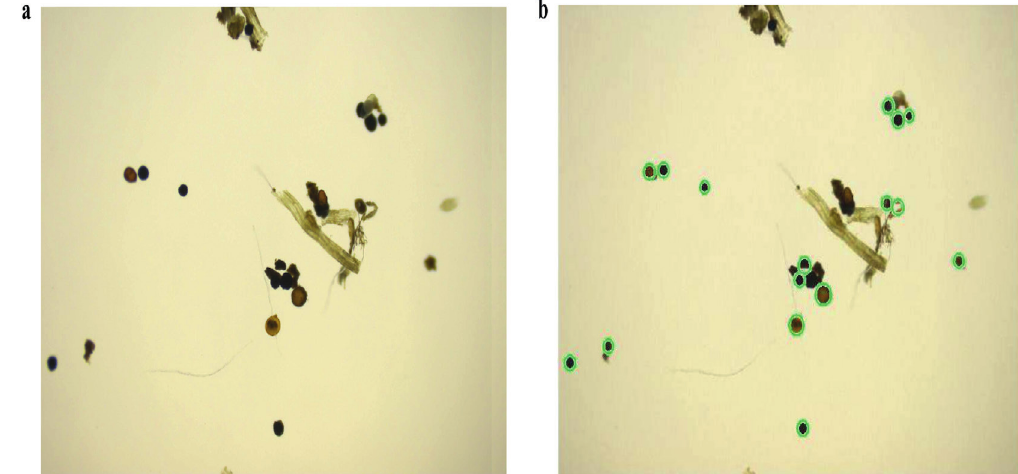
Figure 1 - Original Image (a) ; Patterns found by CHT in original image (b)